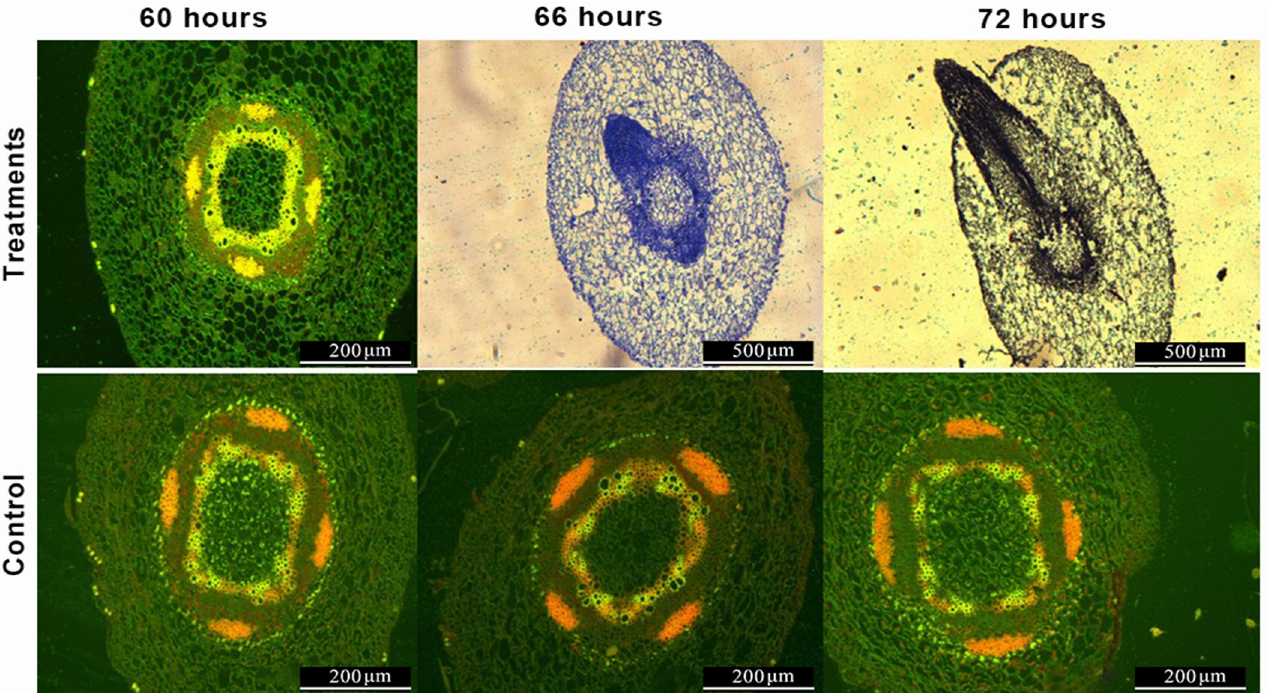
Figure 1. Anatomical structure of adventitious root formation over time in the hypocotyl of R. pseudoacacia . Three developmental stages were observed at 60 h, 66 h, and 72 h for control and treatment with NAA application. Control did not exhibit any change at tested time points but donor treated showed significant changes at three tested time points. At 60 h small cells started division near vascular bundles and gathered to form adventitious roots at 66 h and at 72 h. The scale bar for pictures of the control was 200 µm. For treatment, only 60 h was at 200 µm but the other two time points (66 h, 72 h) were 500 µm.